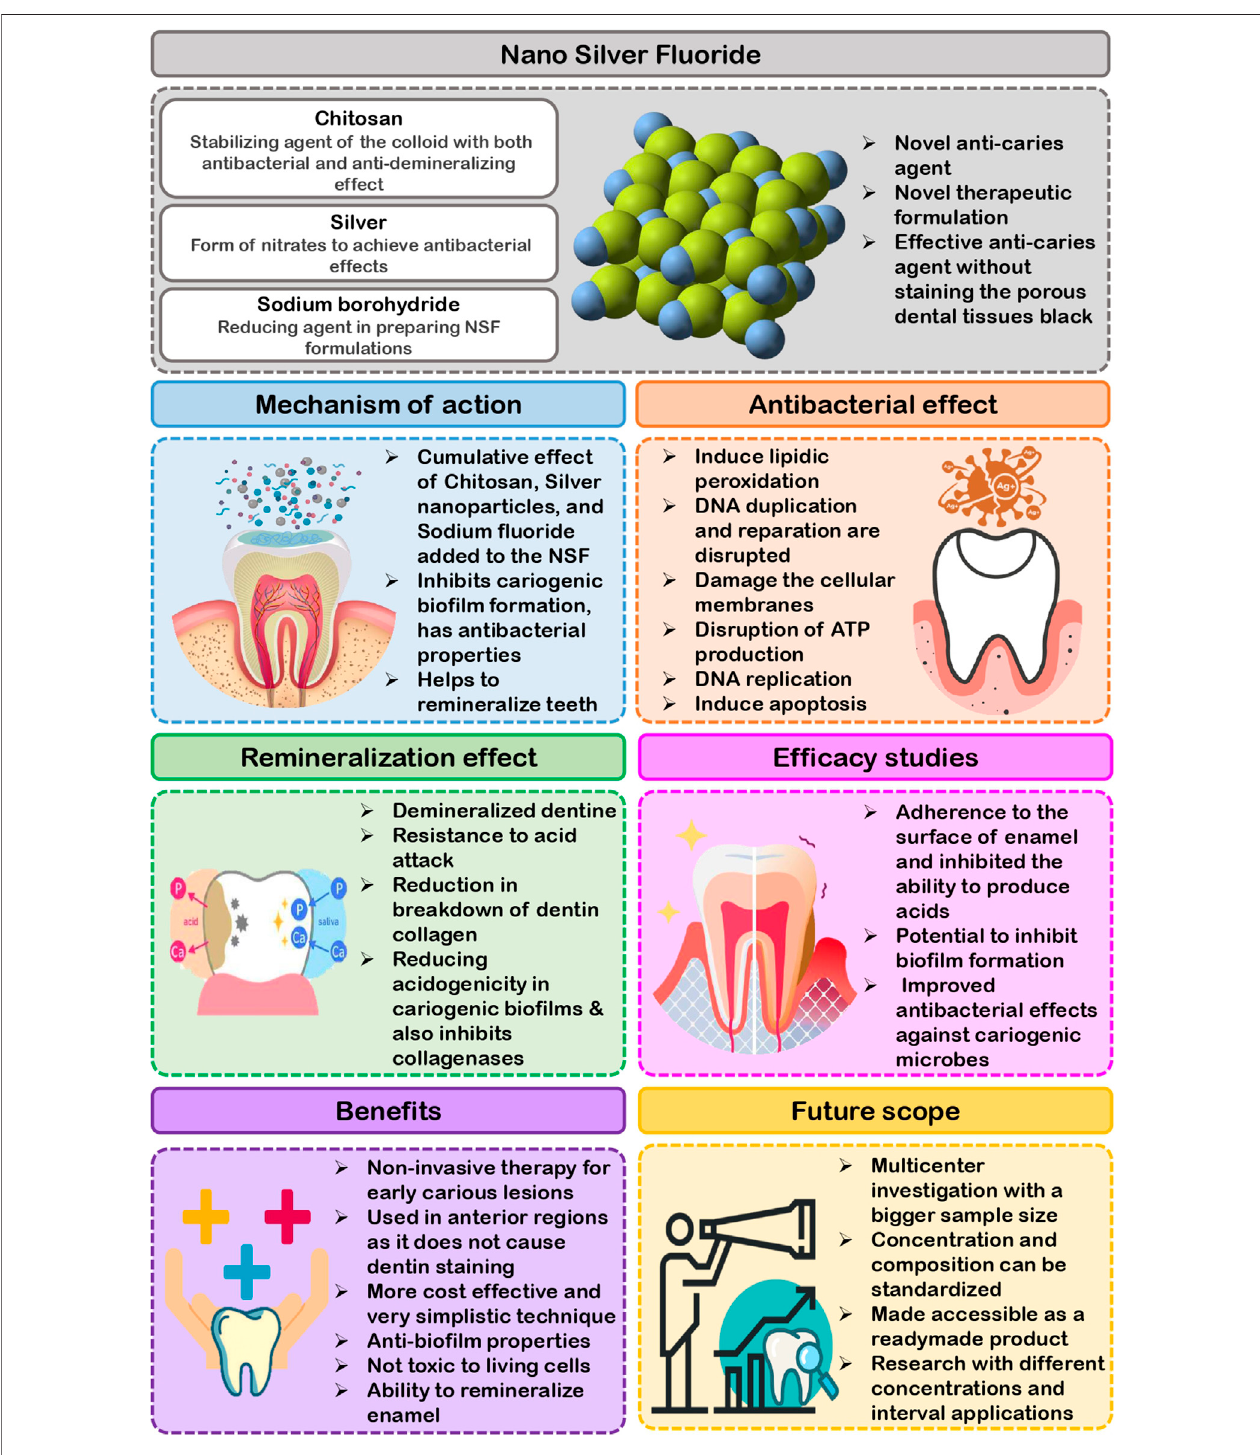
FIGURE 1 | Highlights on Nano Silver